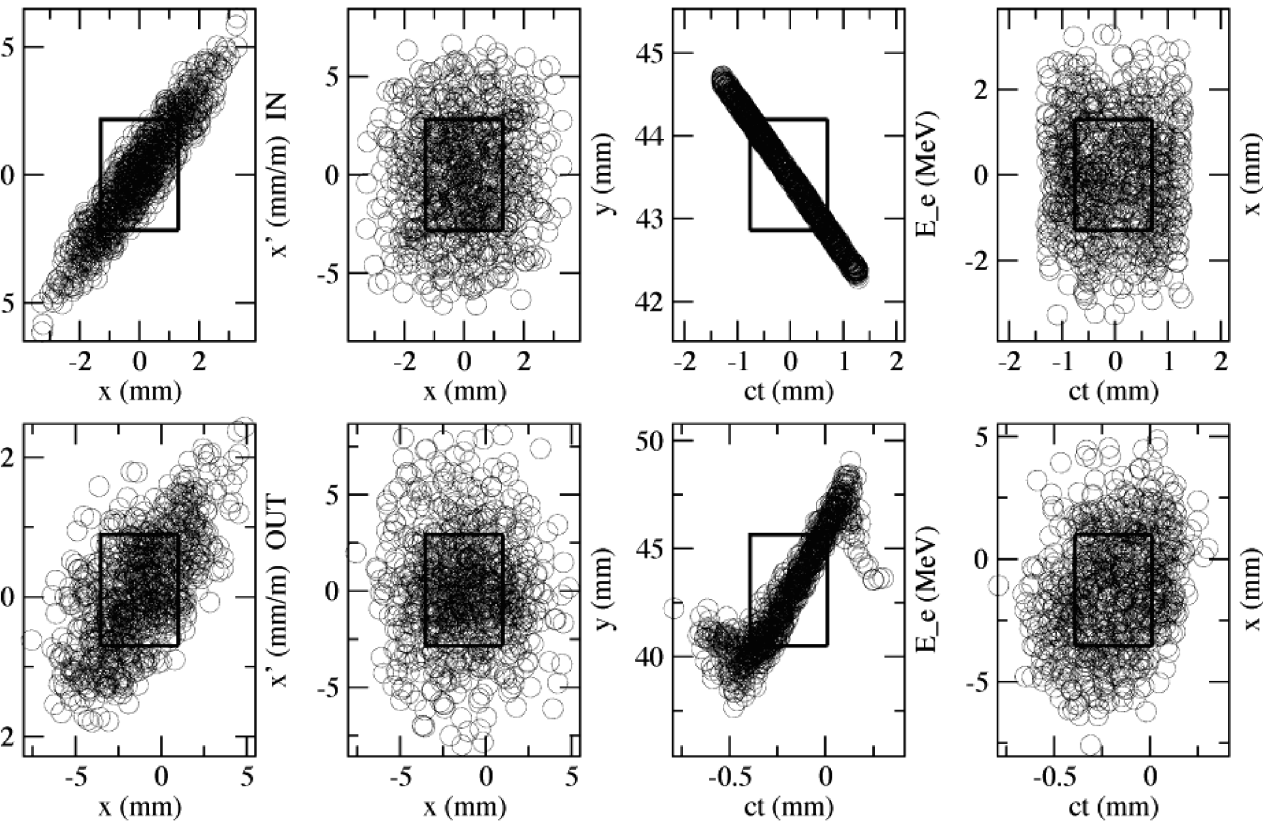
¼ 48 mm . These graphs correspond to the point in 56 ; y ; ct ; (cid:3) Þ ¼ ð 1 : 3% ; 2 : 7% ; hw hw hw hw